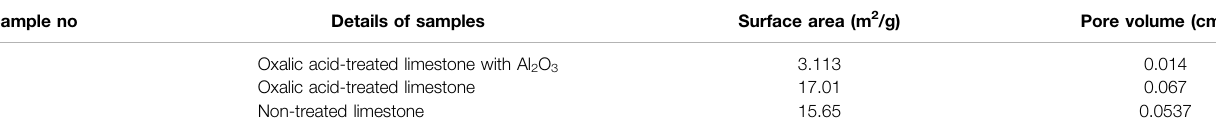
TABLE 2 | Surface area and pore volume of limestone.